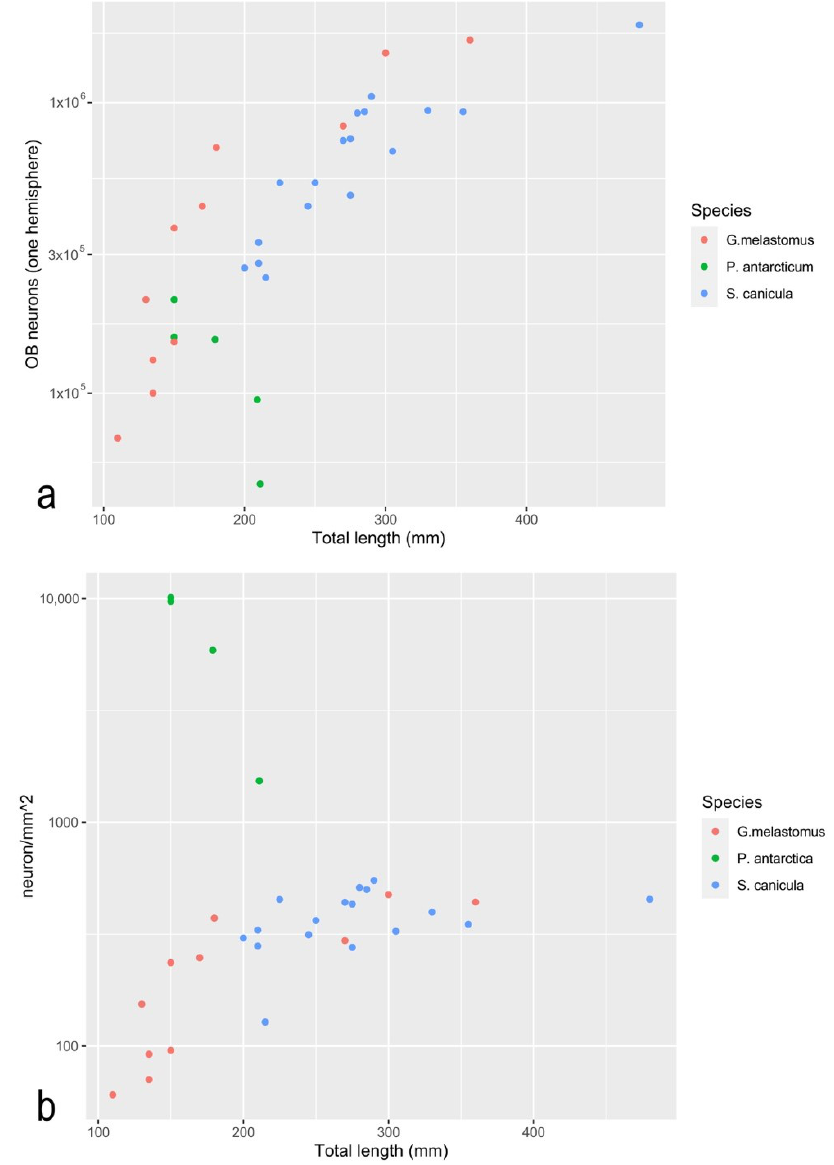
Figure 7. Scatterplots representing part of data in Table 2. Quantitative data from olfactory rosette and bulb of P. antarcticum (present work), and G. melastomus and S. canicula [51]. ( a ) Scatterplot showing the number of neurons in one olfactory bulb. ( b ) Scatterplot showing the number of neurons in one olfactory bulb normalized to the mm 2 of surface area of the olfactory